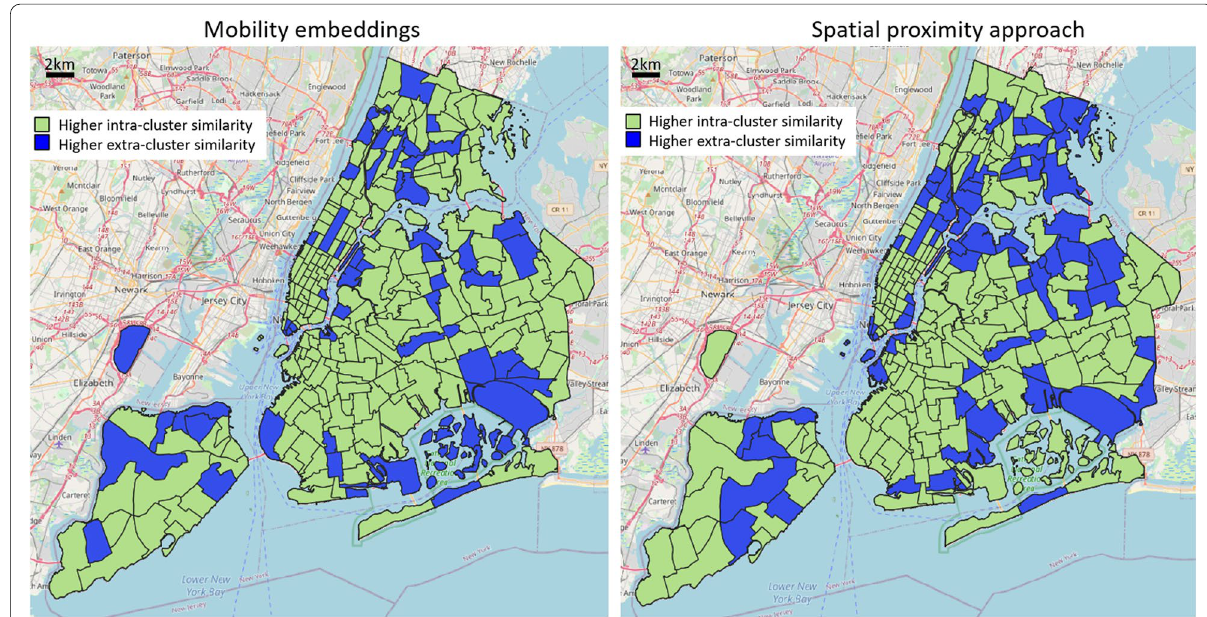
Fig. 10 Assessment of functionality cluster consistency according to different POI-based functionality classes (cater, public facility, shopping, life service, accommodation service). Results are reported in terms of “winning” or “losing” similarity scores for each reference